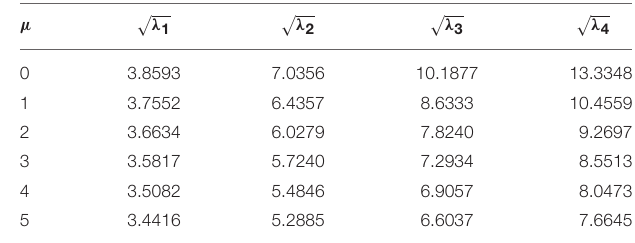
TABLE 12 | Frequency parameters parameters.